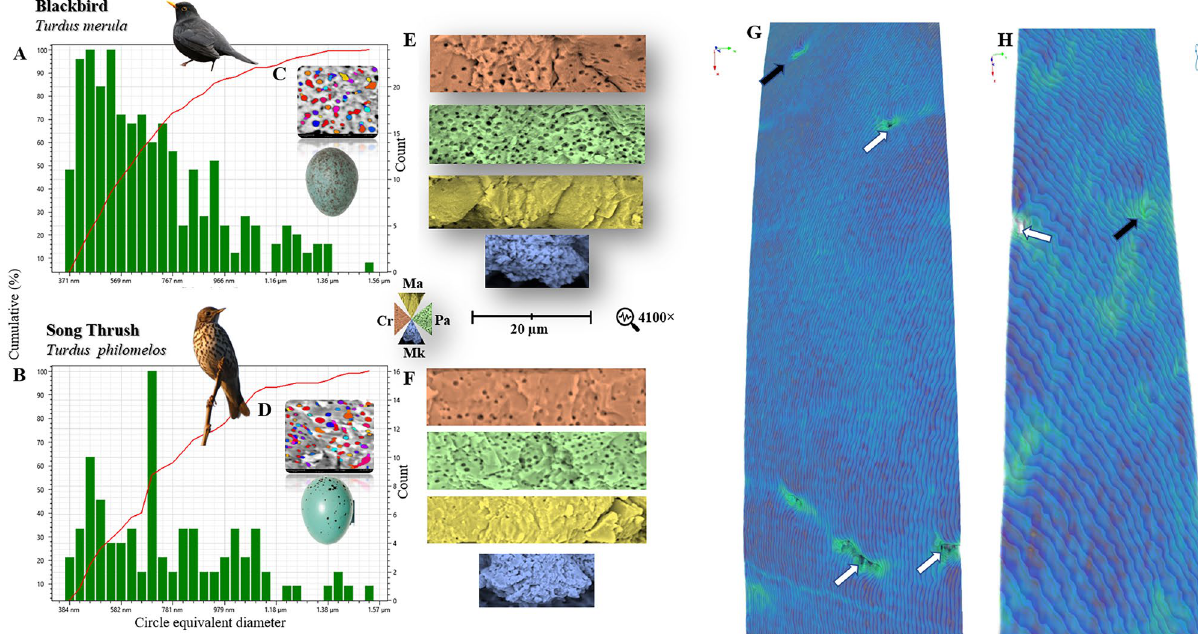
Figure 5. Porosity of blackbird and song thrush eggshell. Histograms ( A ) and ( B ) show the distribution of pores of different diameters as measured by PoroMetric with Phenom scanning electron microscope (images C and D ). The SEM micrographs ( E ) and ( F ) (animated and colored) show the differences in the porosity of crystalline layer (Cr), palisade layer (Pa), and mammillary layer (Ma) as well as the ultrastructure of mammillary knobs. The 3D scans ( G ) and ( H ) show the surface of the eggshells of blackbird and song thrush, indicating open (white arrows) and closed porosity (black arrows).